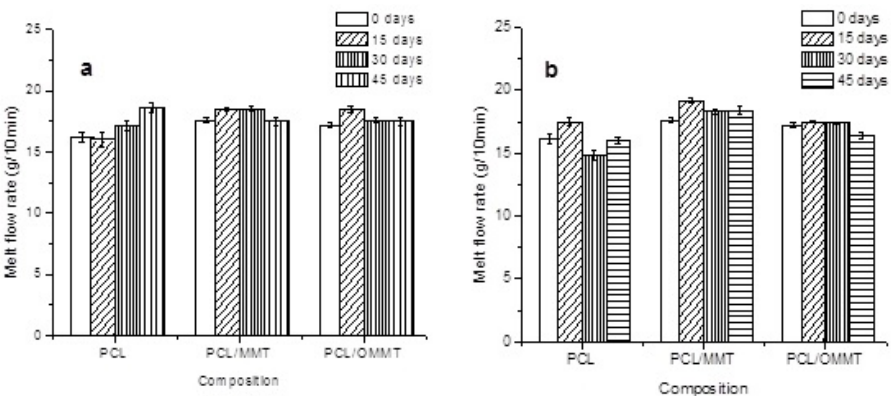
Figure 4. Melt flow rate measurements of PCL, PCL/MMT and PCL/OMMT compounds; under vacuum and temperature (a), under water and temperature (b). (Exposure time indicated).